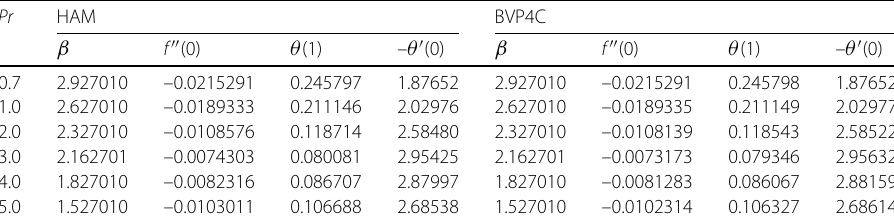
Table 7 Comparison of the values of β = Υ Mathematica package BVPh2.0 approximation and BVP4C for the case β = 0.2, I 0 = 0, λ = 0.2, A = 0.3, N = 0.2, S = 0.4, Ma = 1, M = 1 and several values of